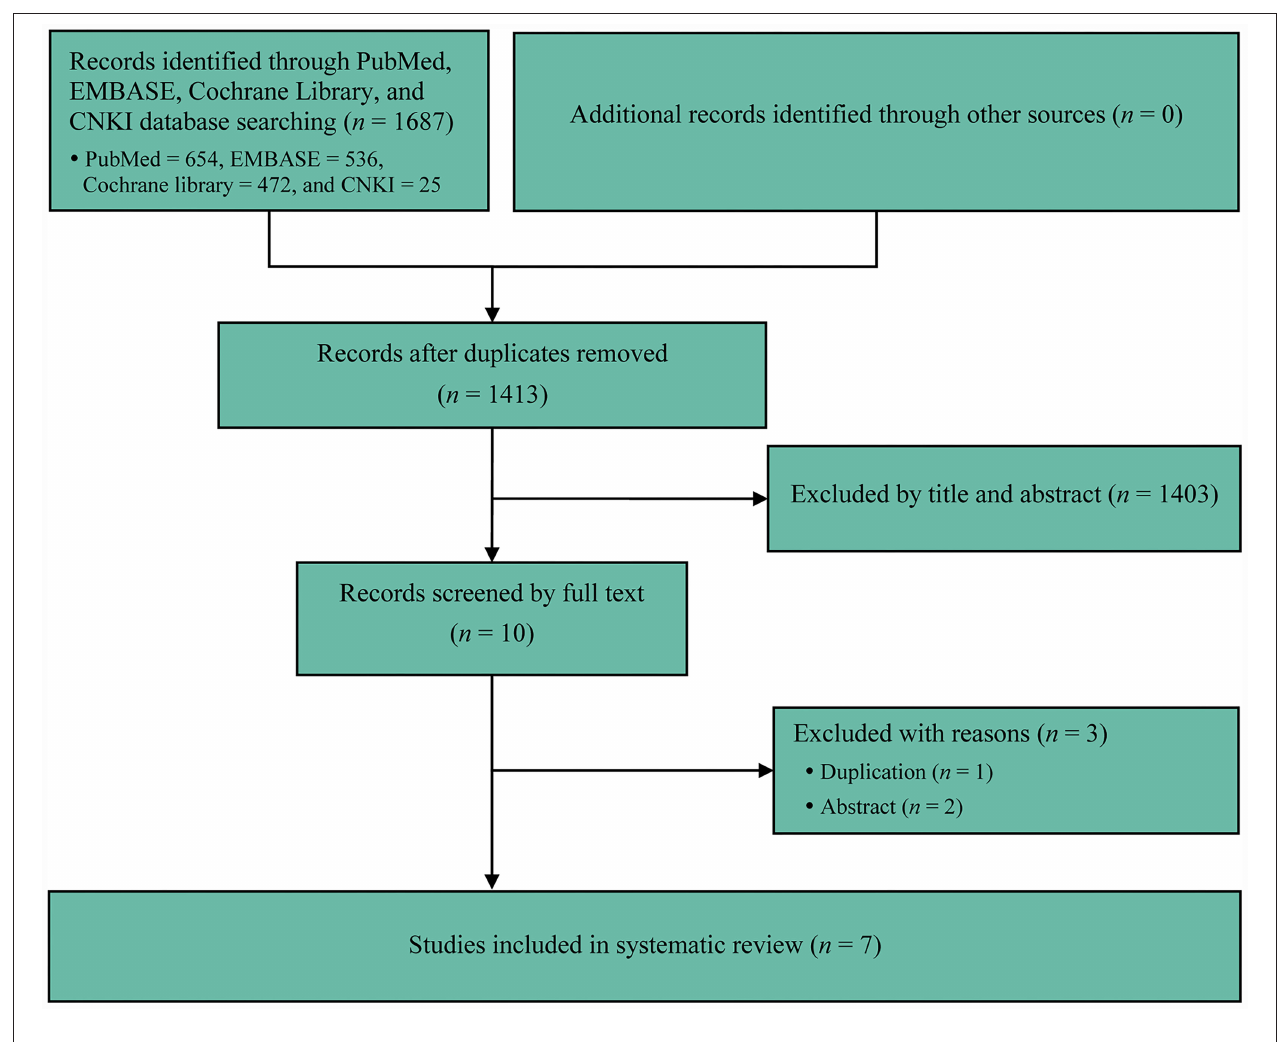
FIGURE 1 | Flow diagram of identification and selection of